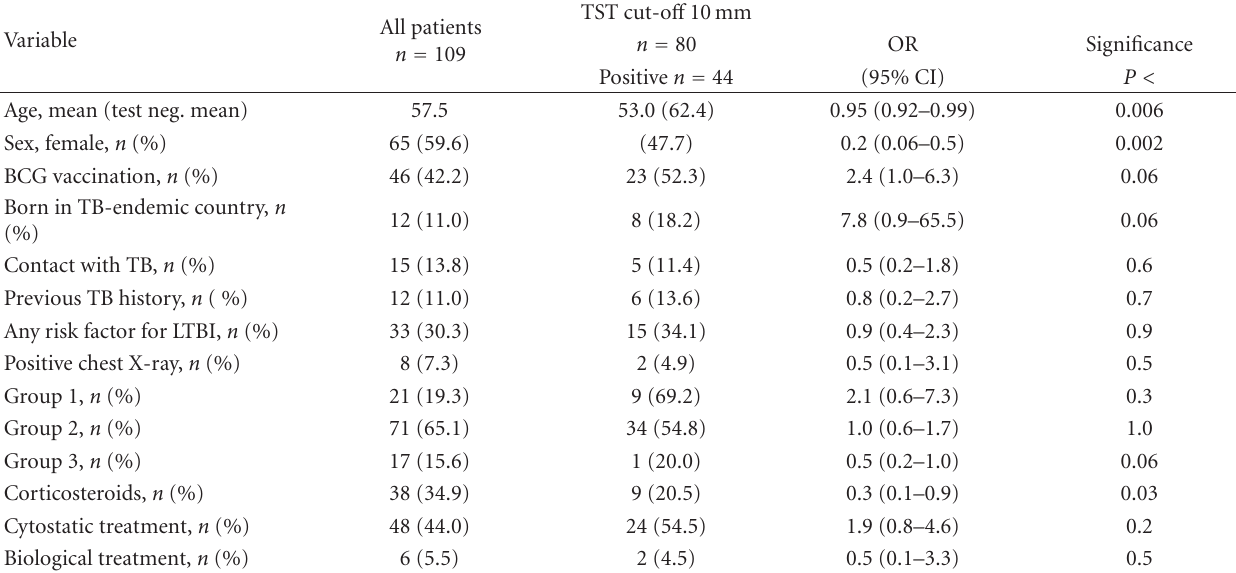
Table 5: The univariate analysis of the TB risk factors with a positive outcome for TST.